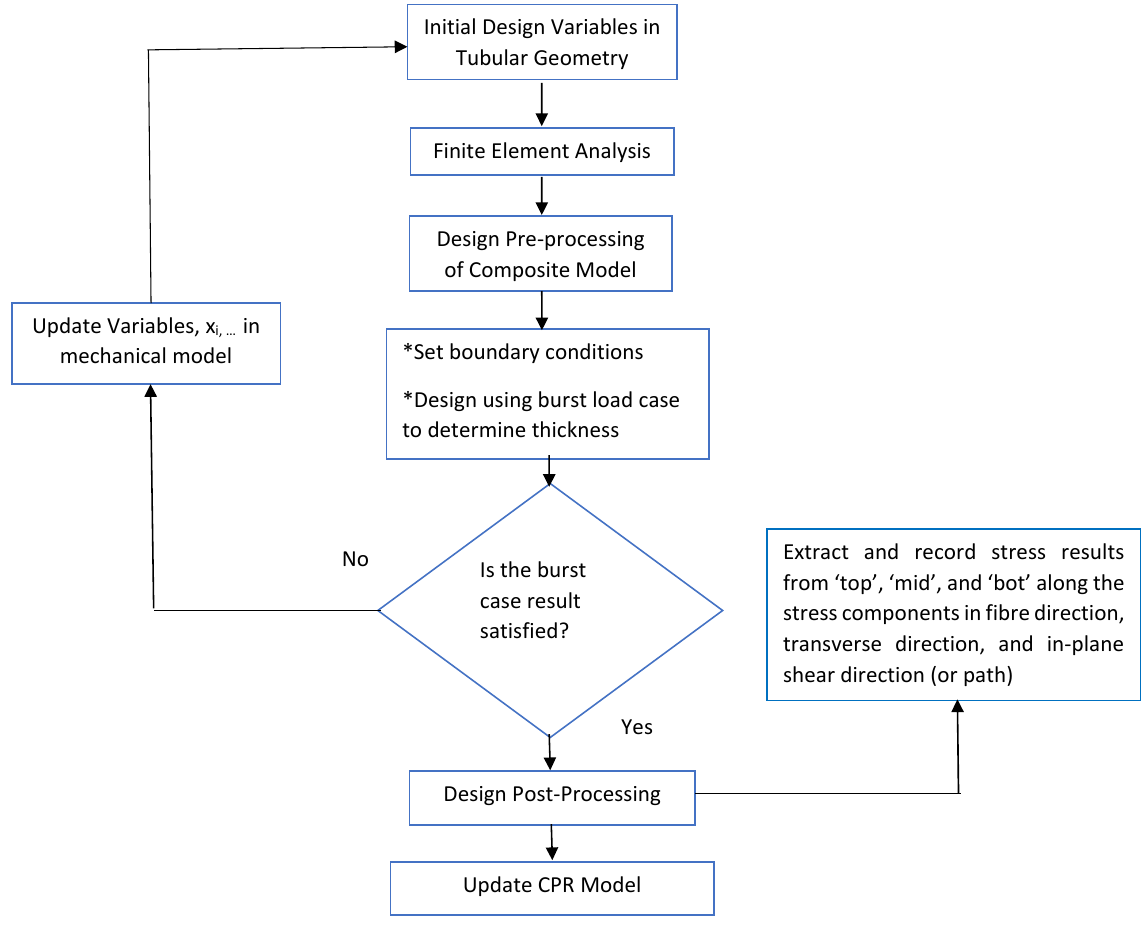
Figure 6. Simplified methodology for the design